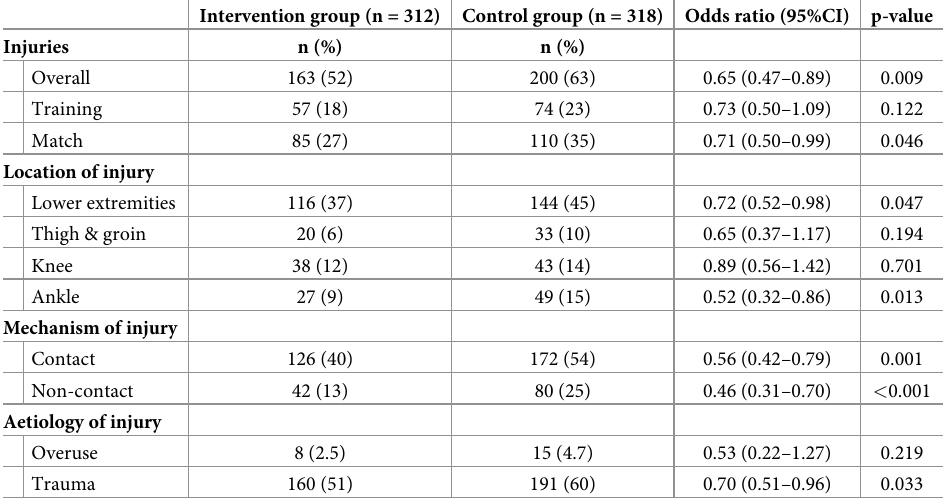
Table 3. Effect of the intervention on the risk of injuries between study